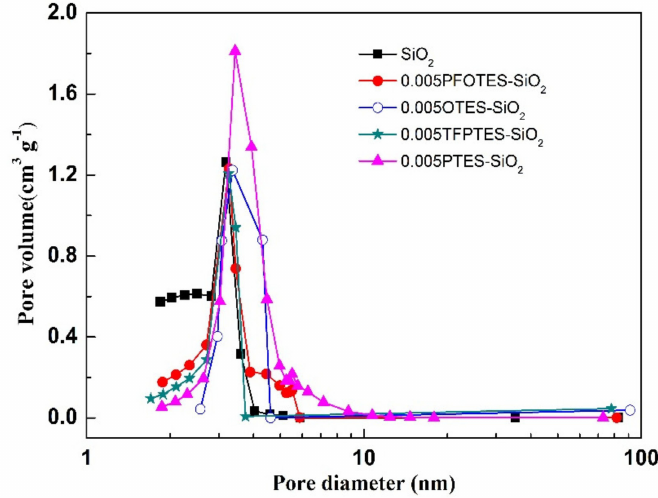
Figure 7. Pore size distribution of pristine and silylated silica